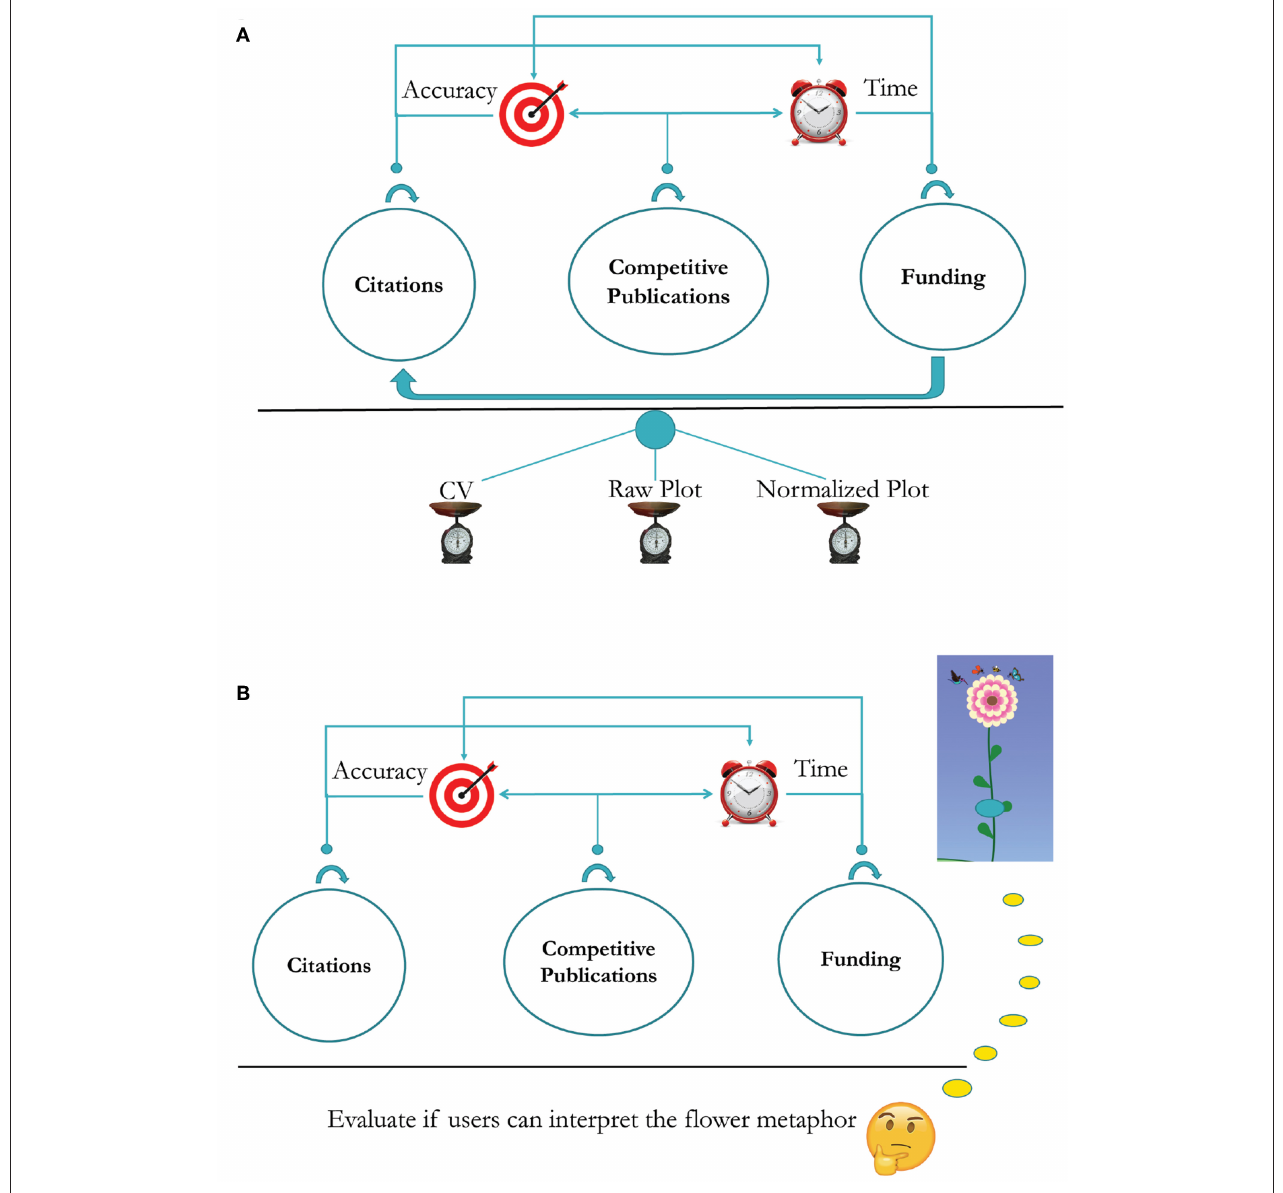
FIGURE 4 | (A) Survey design for the plot form of SP. (B) Survey design for the iconic form of